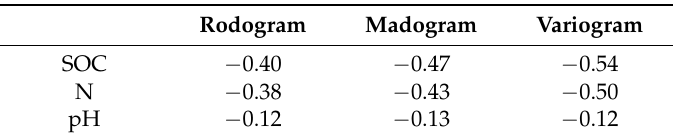
Table 1. Pearson correlation coefficients between soil properties and fractal dimensions calculated by rodogram, madogram and variogram